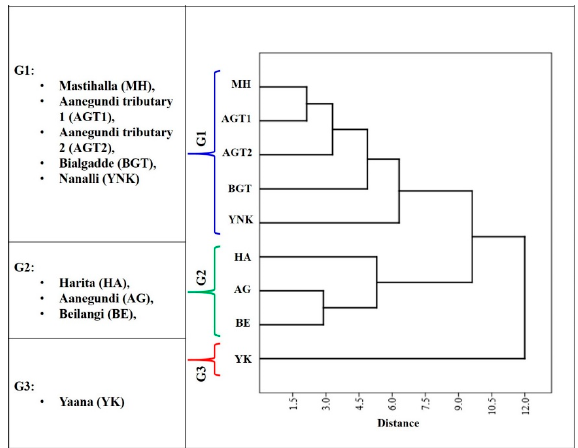
Figure 8. Dendrogram highlighting grouping of monitored streams based on physicochemical char- acteristics